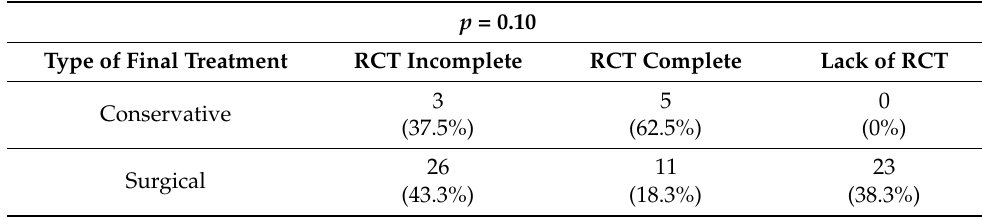
Table 4. The amount and percentage of patients in each treatments group and the quality of root-canal treatment.